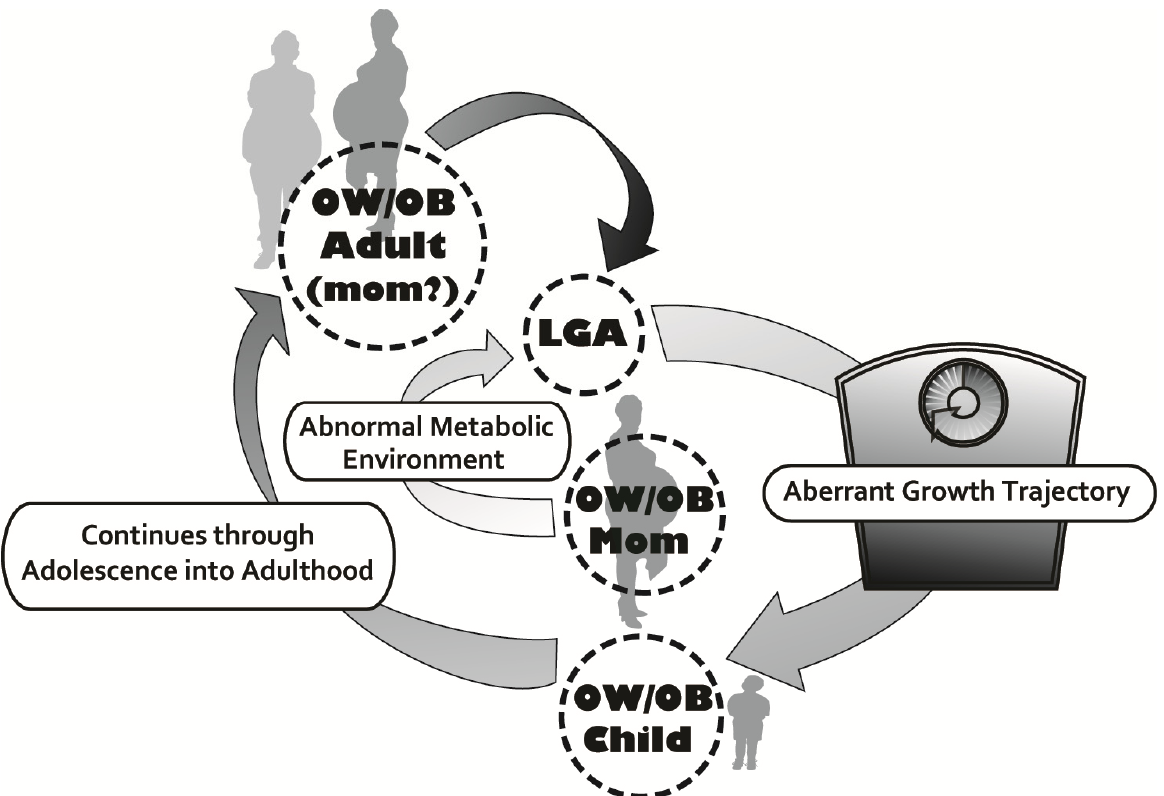
Figure 4. Obesity begets obesity through accelerated growth trajectory without intervention. LGA-large for gestational age,